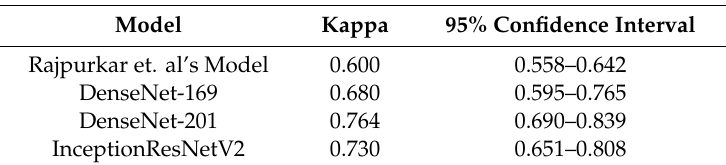
Table 3. Model Performance Summary—Humerus. Table 2b. Model Performance Summary—Humerus.